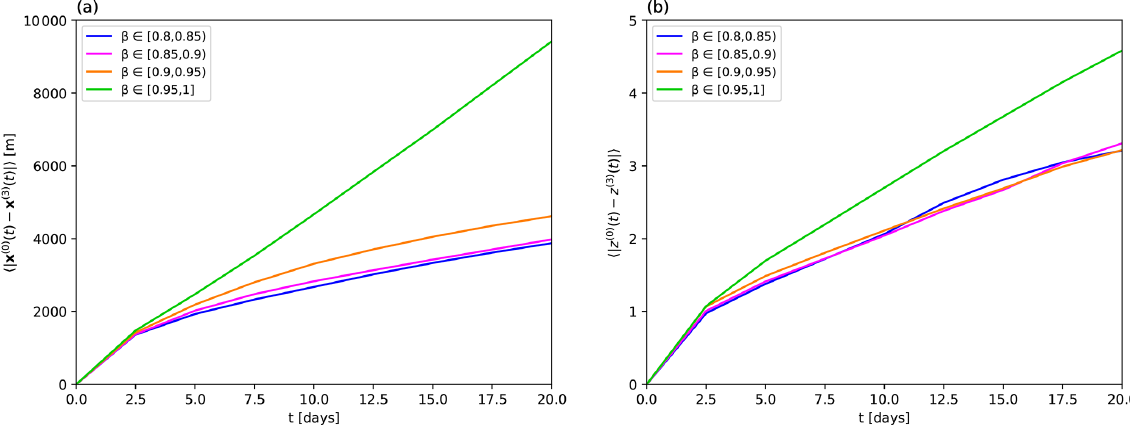
Figure B4. Same as Fig. B3 for the comparison of Eqs. (1) and